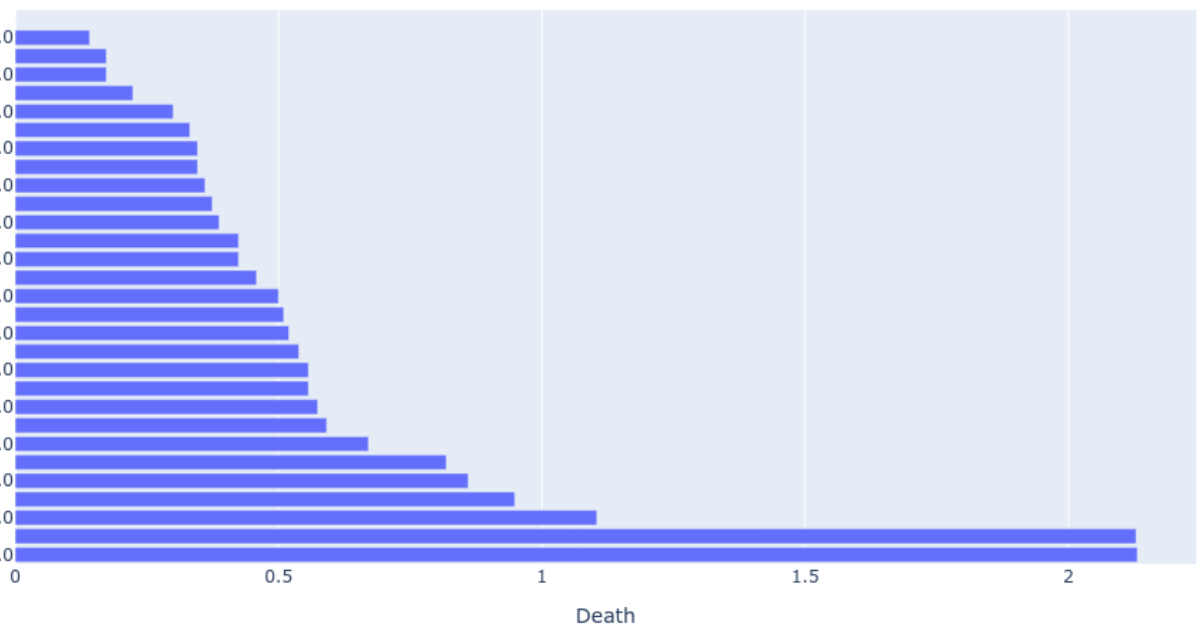
Figure 8. Bar Code result from 0-dimensional Homology analysis in Arduino M0+ Pro platform. The analysis was obtained by randomly sampling 32 samples from the IRIS